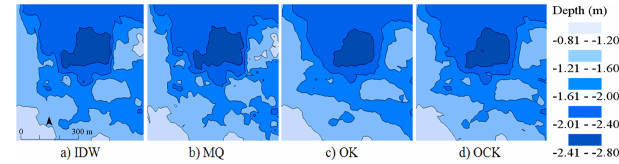
Figure 10. Representation of contours in part of the lake (difference between interpolation